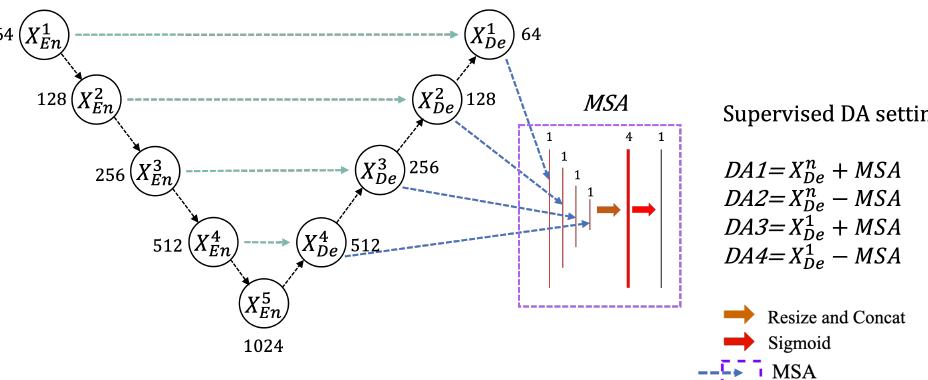
Figure 8. A schematic representation of the four settings of supervised DA. X n where n ∈ [ 1,4 ] En represents the encoder blocks, X 5 represents the bottleneck, X n where n ∈ [ 1,4 ] represents the De En decoder blocks, and MSA represents the multi-scale feature aggregation block of our MSA-UNET. The accuracy measures obtained on the TR2 dataset along with the time taken for the